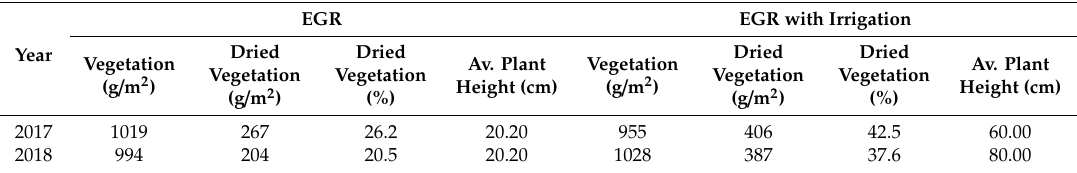
Table 6. Comparison of plant height and vegetation mass on a conventional EGR and an irrigated EGR for 1 m 2 . The irrigated EGR got 5 L / m 2 / day in the vegetation period over 2 years. The green roof was located at the ufaFabrik,